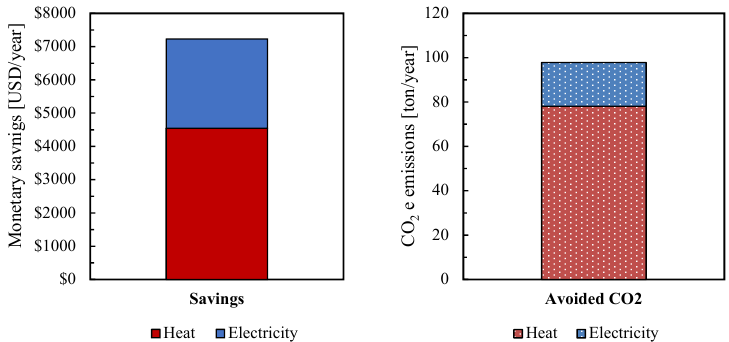
Figure 8. Annual monetary savings ( left ) and avoided CO 2e emissions ( right ) (Source: Author own calculation).